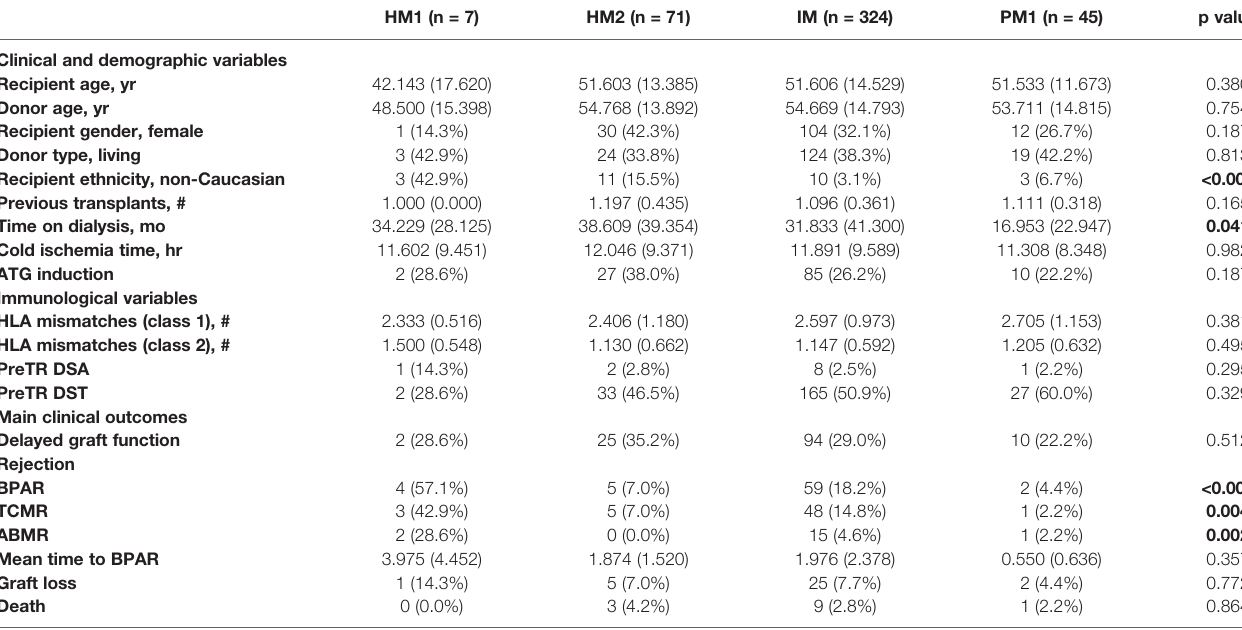
TABLE 2 | Main clinical, demographical and immunological characteristics between the four different TAC metabolizing